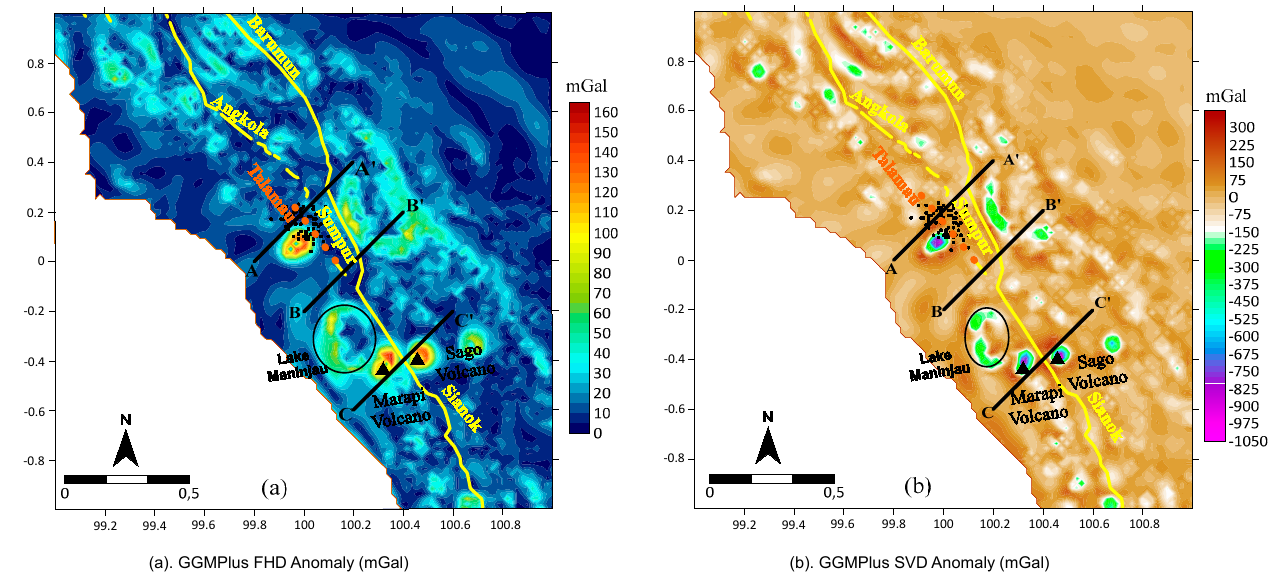
Figure 11. ( a ) FHD anomaly and ( b ) SVD anomaly. Faults are symbolized by a black straight line, volcanoes are represented by a black triangle, the alleged Talamau fault is symbolized by a orange dotted line, Lake Singkarak is symbolized by a blue ellipse, and slicing is symbolized by a black straight line.